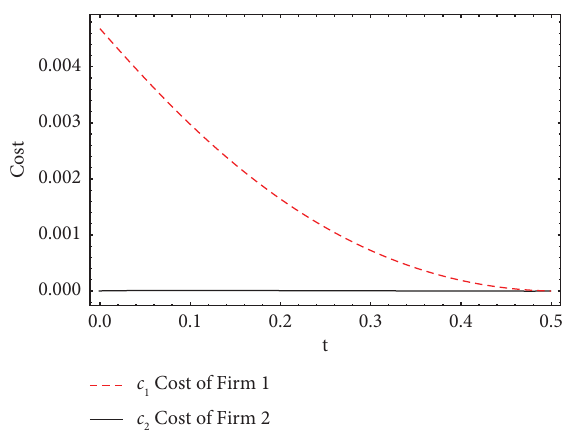
Figure 3: Te advertising cost function of frm 1 and frm 2 at the time t .